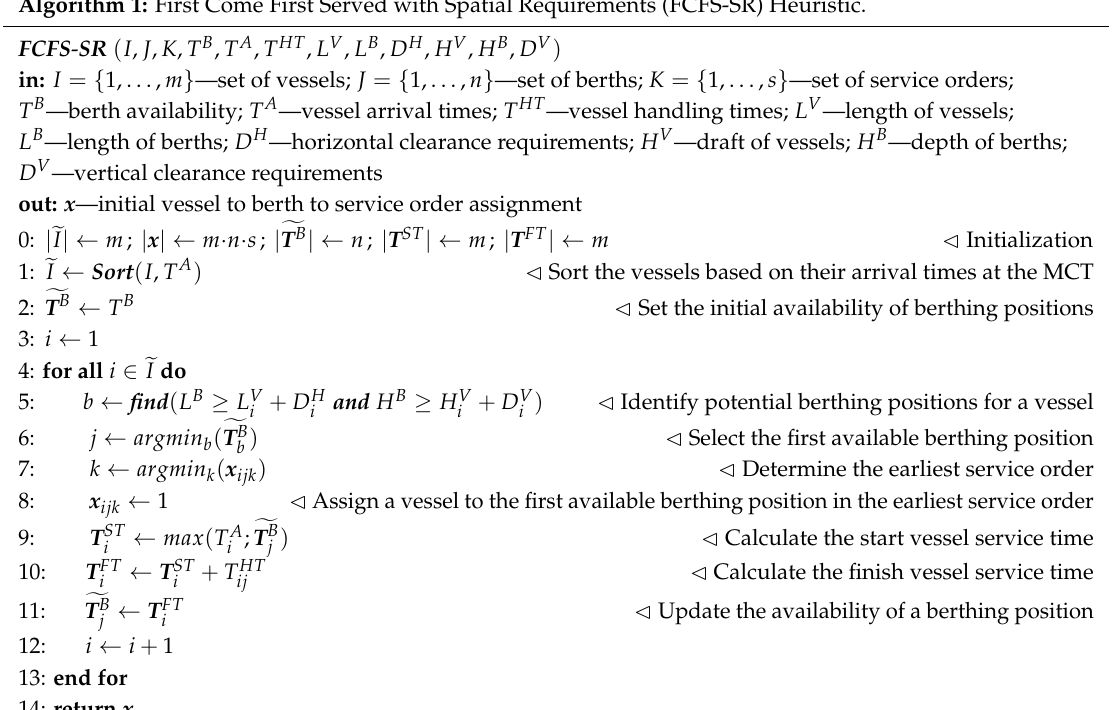
Algorithm 1: First Come First Served with Spatial Requirements (FCFS-SR) Heuristic. FCFS - SR ( I , J , K , T B , T A , T HT , L V , L B , D H , H V , H B , D V ) in: I = { 1, . . . , m } —set of vessels; J = { 1, . . . , n } —set of berths; K = { 1, . . . , s } —set of service